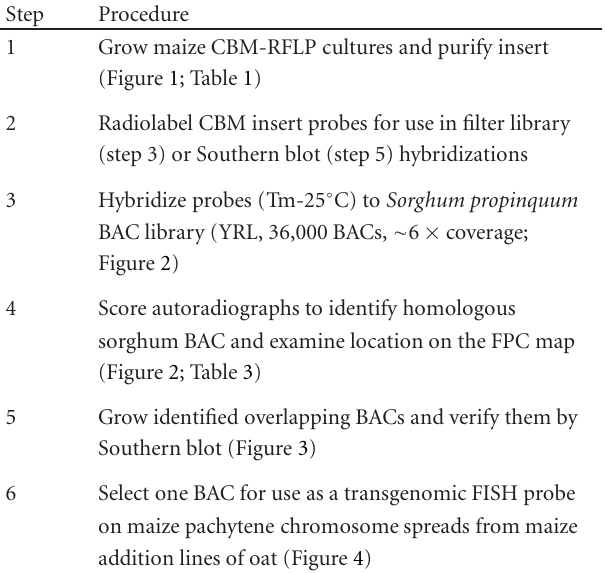
Table 2: Major steps in the identification and maize marker-based selection of a sorghum BAC for use as a transgenomic FISH probe in maize. The figures and tables corresponding to the steps are